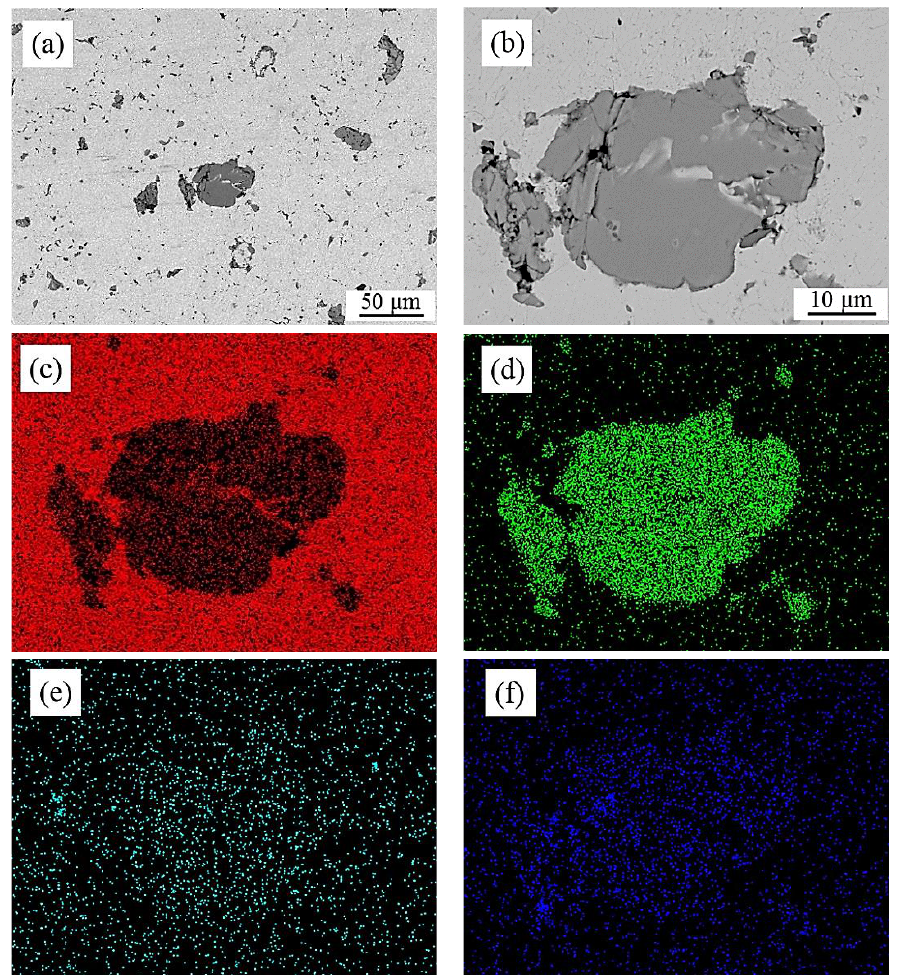
Figure 10. Typical morphology and EDS mapping of Ti 3 AlC 2 /Cu composites coated with Ti when the volume fraction of Ti 3 AlC 2 is 10 vol.%: ( a ) SEM micrograph under low magnification, ( b ) SEM micrograph under high magnification, ( c ) scanning results of the Cu element, ( d ) the Ti element, ( e ) the Al element and ( f ) the C element.